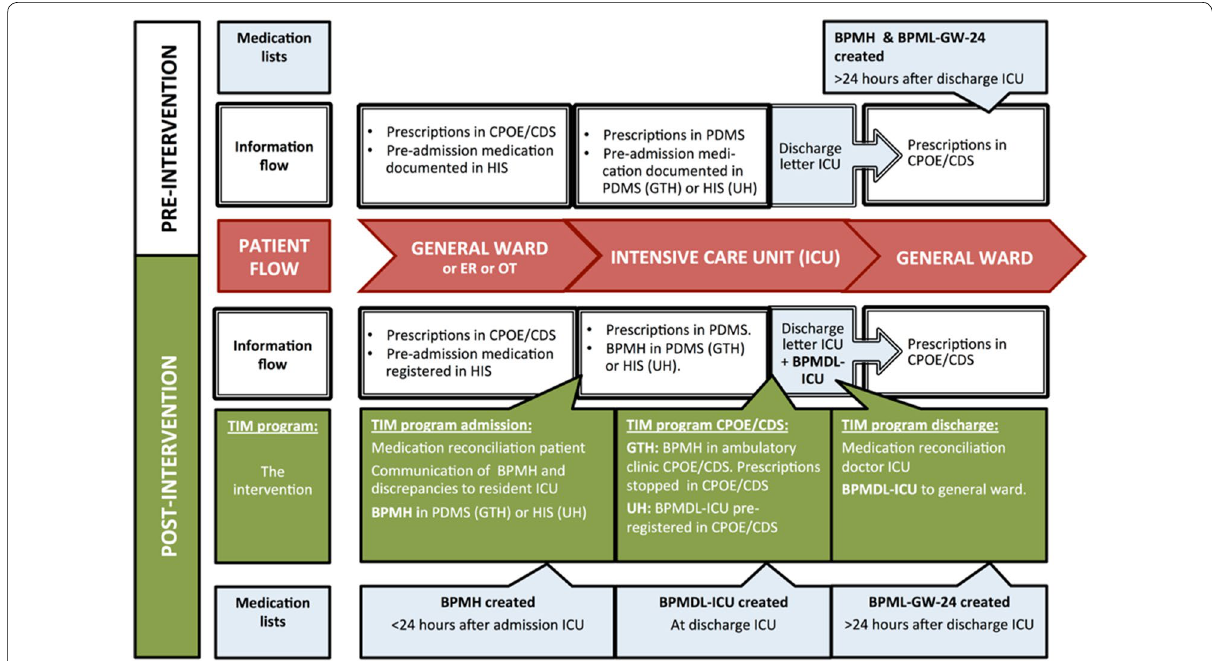
Fig. 1 Study procedure pre- and post-intervention. BPMDL-ICU best possible ICU medication discharge list, BPMH best possible medication history, BPML-GW24 best possible general ward medication list 24 h after ICU discharge, CPOE/CDS system computerized physician order entry systems